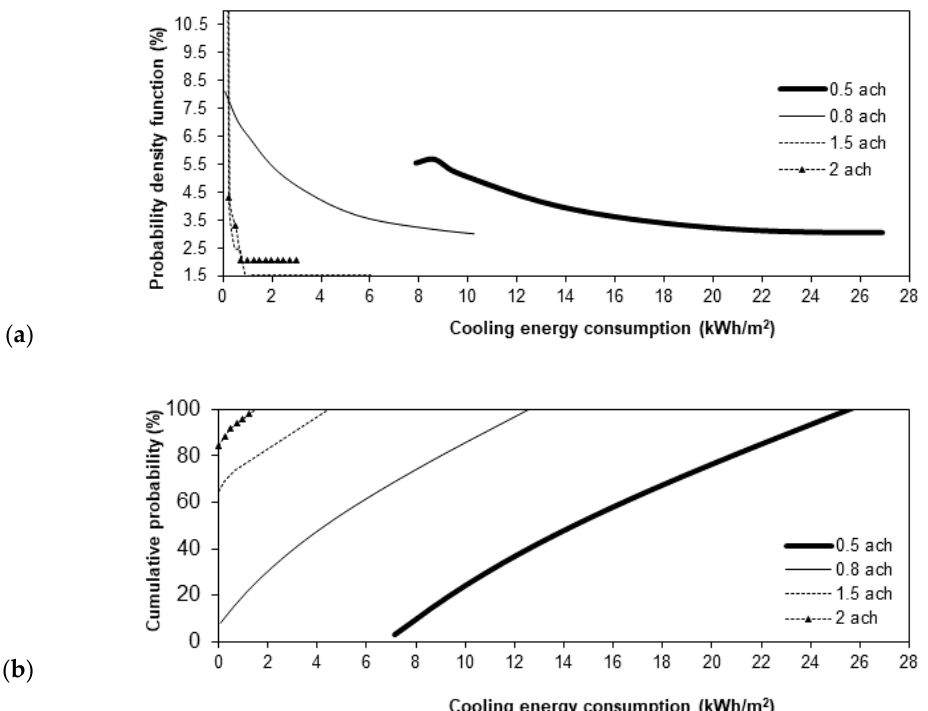
Figure 6. Probability density functions ( a ) and cumulative probability ( b ) of the cooling energy consumption for different air changes (Ach = 0.5, Ach = 0.8, Ach = 1.0, Ach = 2.0).